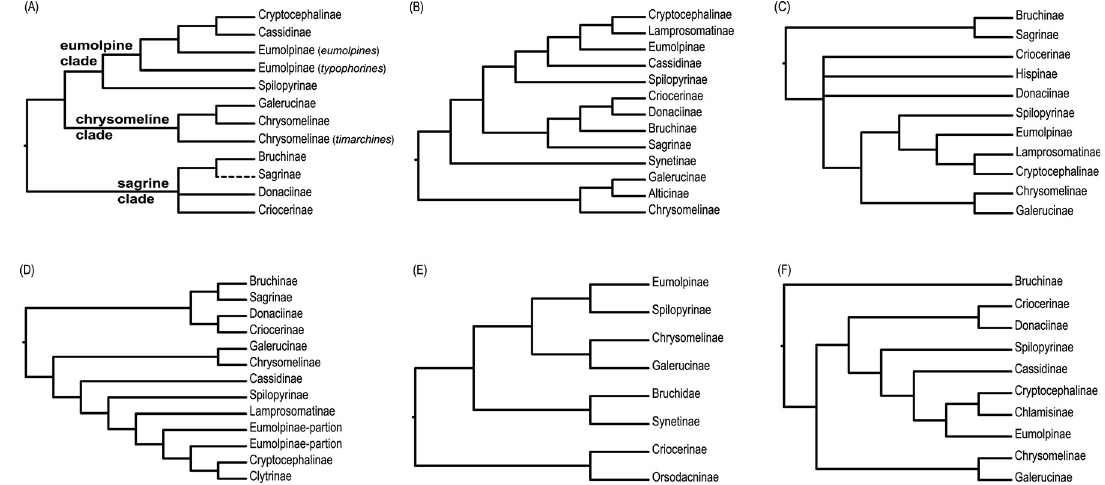
Fig 1. Representations of previous hypotheses for the subfamily-level relationships within Chrysomelidae inferred from morphologically-based or molecular studies by authors cited. (A) Go ´ mez-Zurita at al. (2008) [13] based on molecular data; (B) Nie at al. (2020) [22] based on molecular data; (C) Reid (2000) [26] based on morphological data; (D) Bocak at al. (2014) [11] based on molecular data; (E) Jolivet at al. (2008) [22] based on morphological data; (F) Song at al. (2018) [27] based on molecular data.